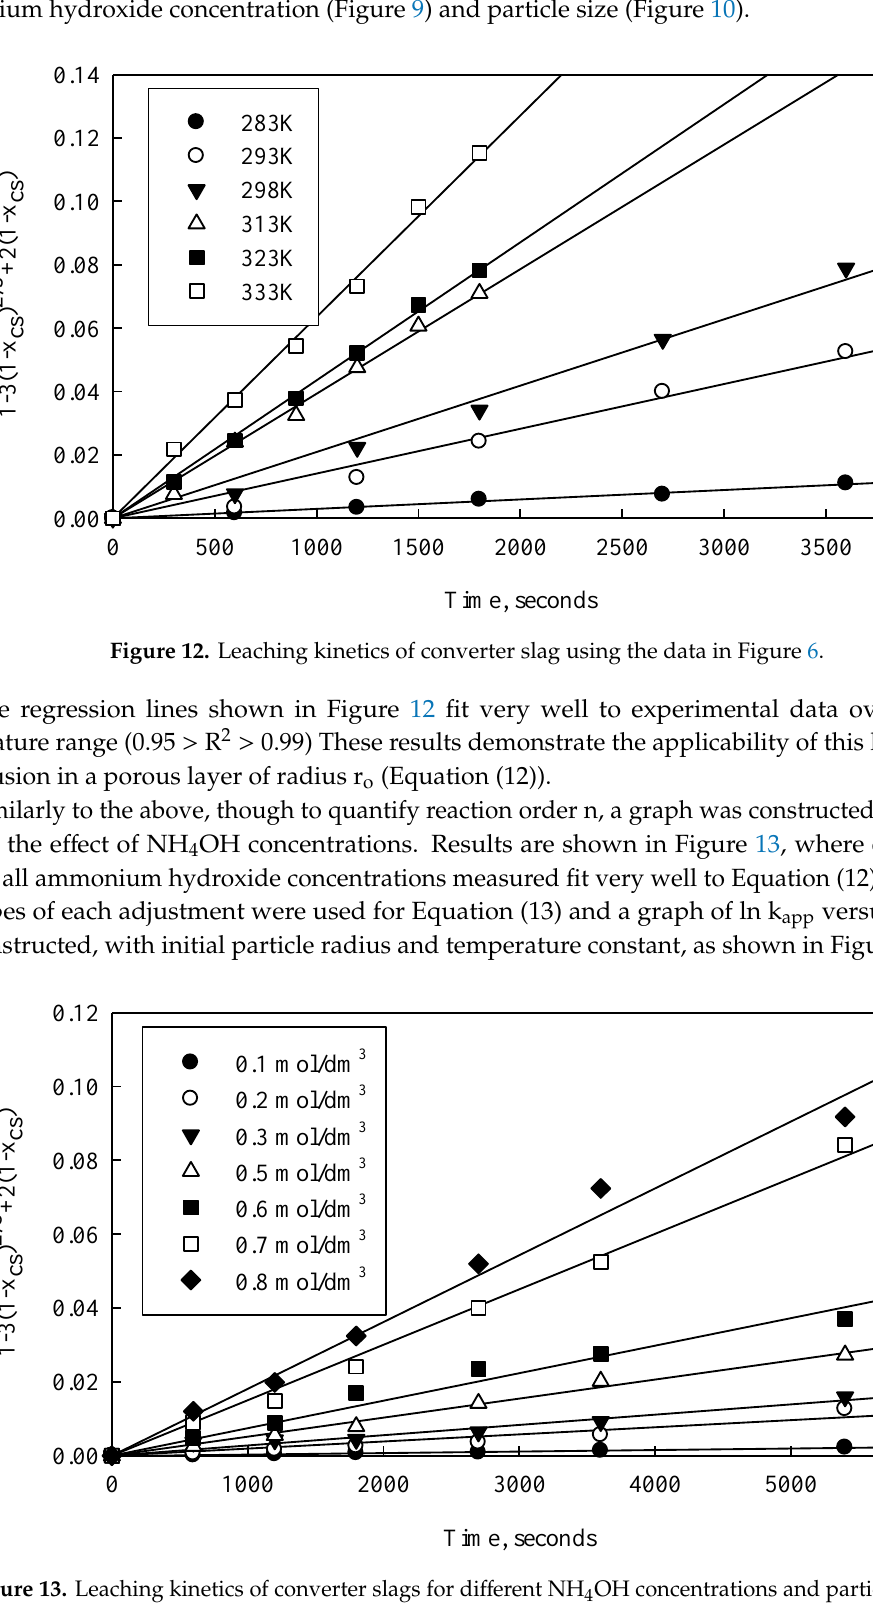
Figure 13. Leaching kinetics of converter slags for di ff erent NH 4 OH concentrations and particle size of 64 µ